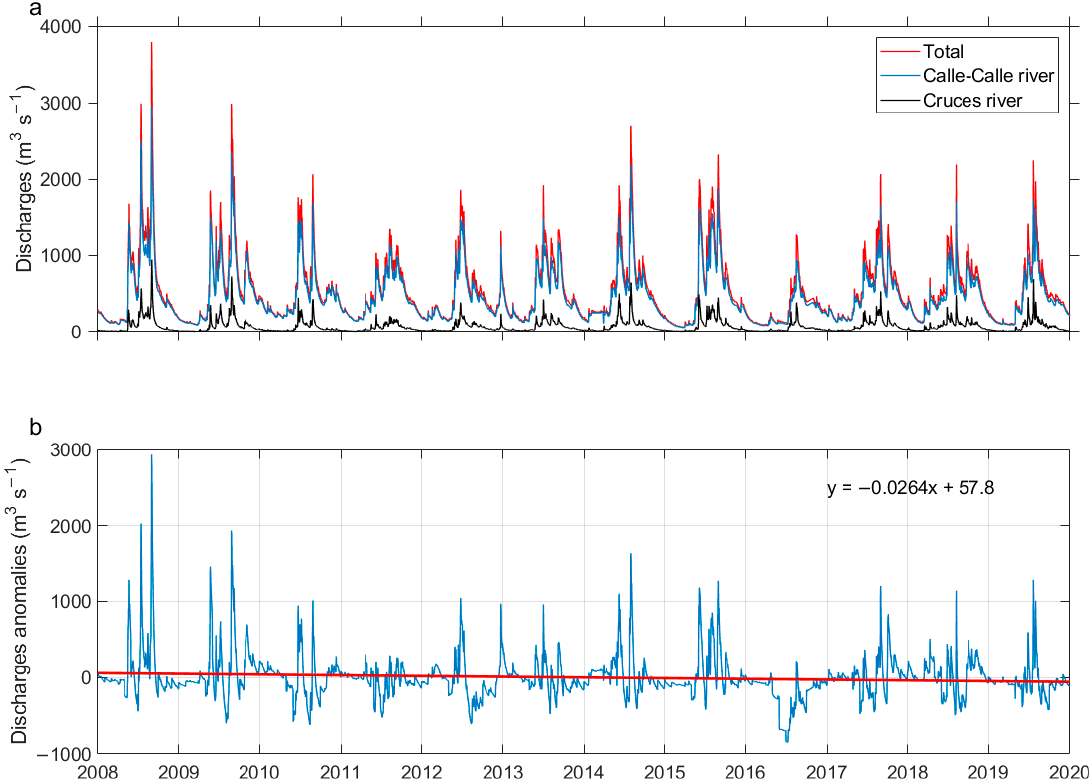
Figure 6. Time series of daily ( a ) river flow of the Calle-Calle (blue line) and Cruces (black line) rivers and sum of both rivers (red line) and ( b ) discharge anomalies of the sum of the Calle-Calle and Cruces rivers. The red line in ( b ) represents the linear trend from 2008 to 2019 and its mathematical representation is shown in the upper right corner. The flow data anomalies were based on the long-term daily means: 2008 and 2019.